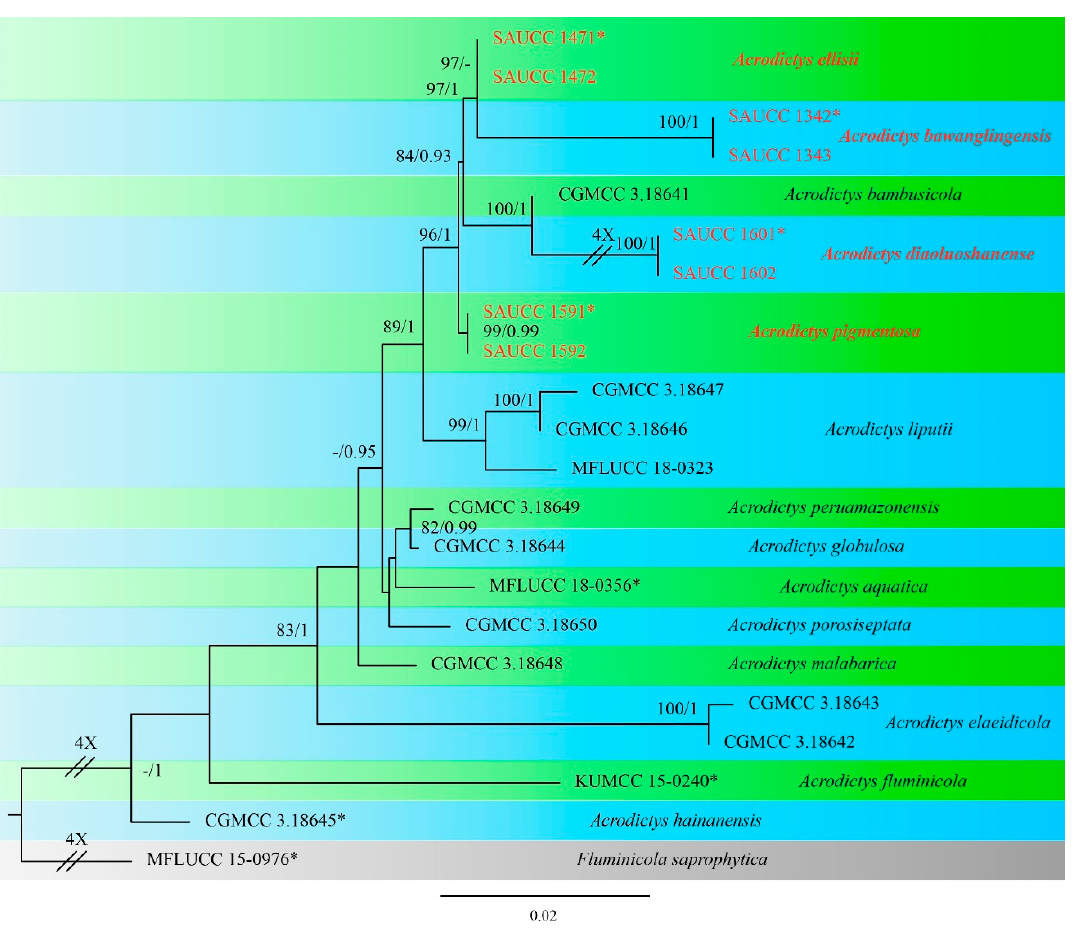
Figure 1. Phylogram generated from RAxML analysis based on combined ITS, LSU, and SSU sequence data, demonstrating phylogenetic relationships within Acrodictys with the Fluminicola saprophytica MFLUCC 15-0976 as outgroup. The maximum likelihood bootstrap value (MLBV ≥ 70%) and Bayesian inference posterior probability (BIPP ≥ 0.90) are shown at relative nodes at the first and second positions, respectively. Strains marked with “*” are ex-types. Strains from this study are shown in red. Three branches were shortened to fit the page size and are indicated by a double slash (//) with a fold number showing how many times they are shortened.